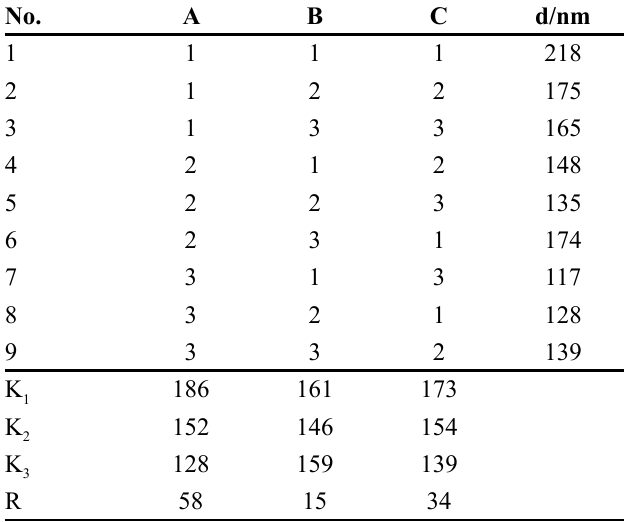
TABLE II - The results of orthogonal test